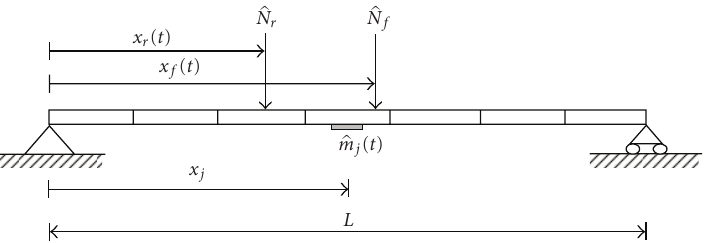
Figure 3: Model of a vehicle and bridge WIM system used for weight estimation with constant magnitude of moving loads assumption.